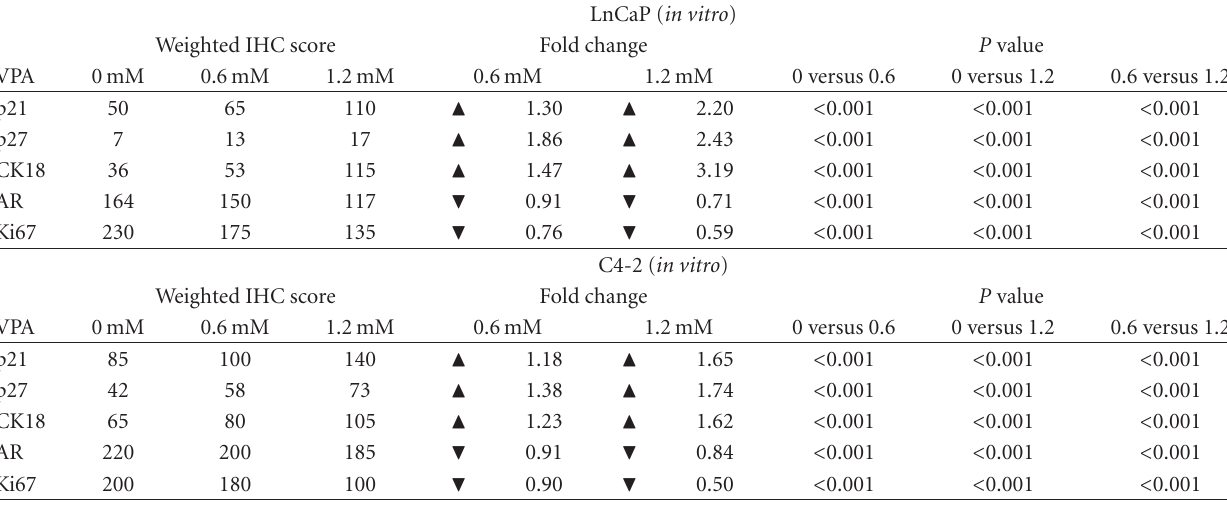
Table 2: Immunohistochemistry staining scores of various markers in tissue microarrays created from cell lines treated with 0, 0.6, and 1.2mM of valproic acid for 14 days.